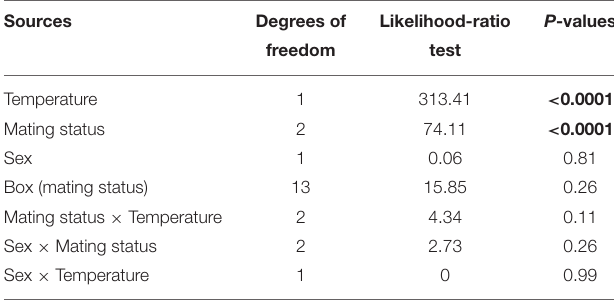
TABLE 1 | Effects of temperature, mating status, sex, box, and the interactions on the hatching rate proportion of surviving individuals after a cold stress event at two different sub-zero temperatures (i.e., − 1.5 and − 5 ◦